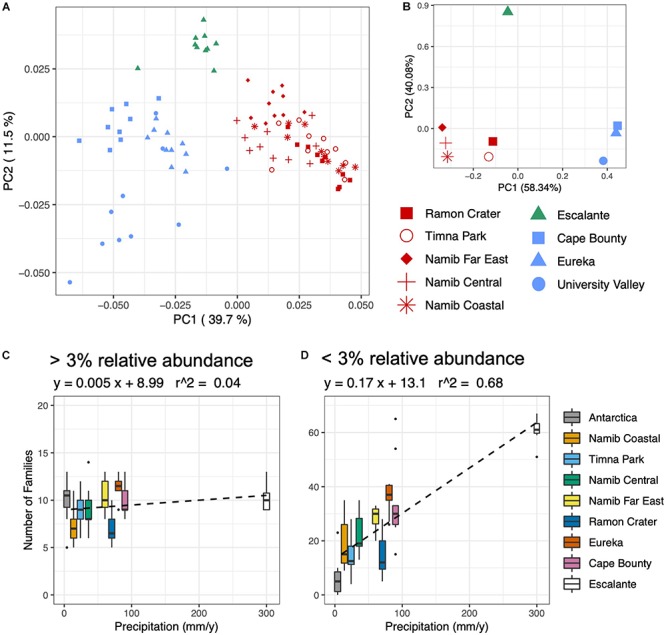
Environmental correlations with bacterial community composition and diversity. (A) Principal coordinates analysis (PCoA) plot of weighted UniFrac distance of the prokaryotic community, based on 16S rRNA gene sequences rarefied to 1500 reads. Sites are colored according to climate regime, with red = hot/dry, blue = polar, and green = temperate. (B) PCA of Euclidean distance of climate variables: average temperature, precipitation, relative humidity, daily solar radiation. (C,D) Boxplots of number of families plotted against yearly precipitation for (C) families comprising over 3% of reads and (D) families comprising below 3% of reads.